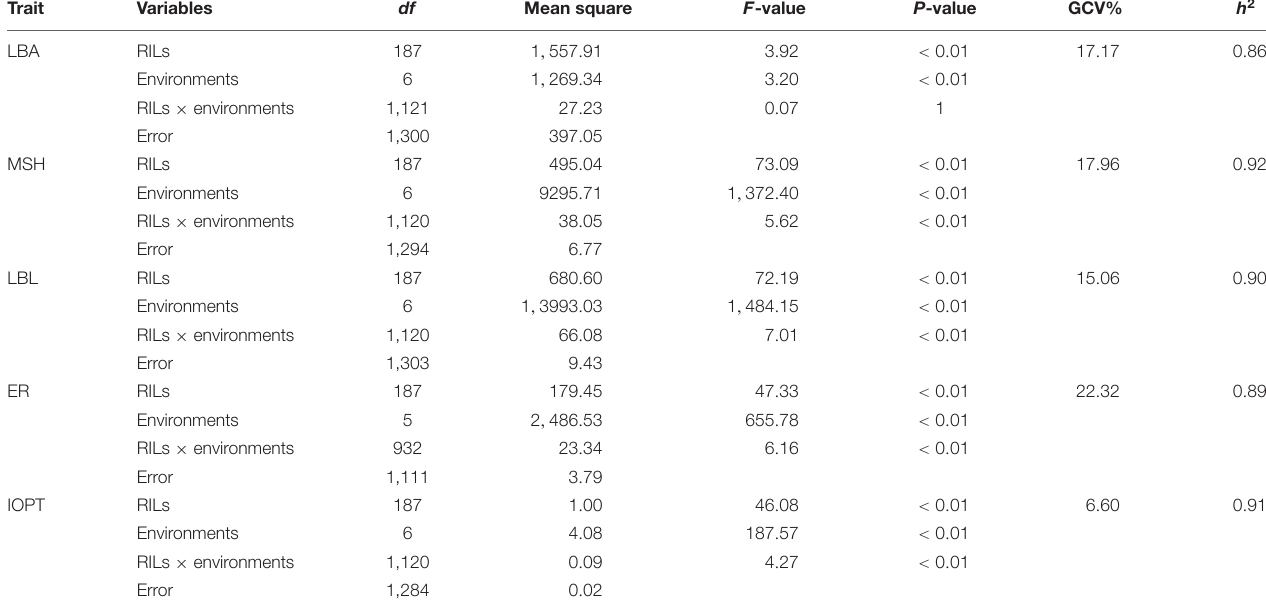
TABLE 2 | Analysis of variance for five traits in the RIL population under seven environments.